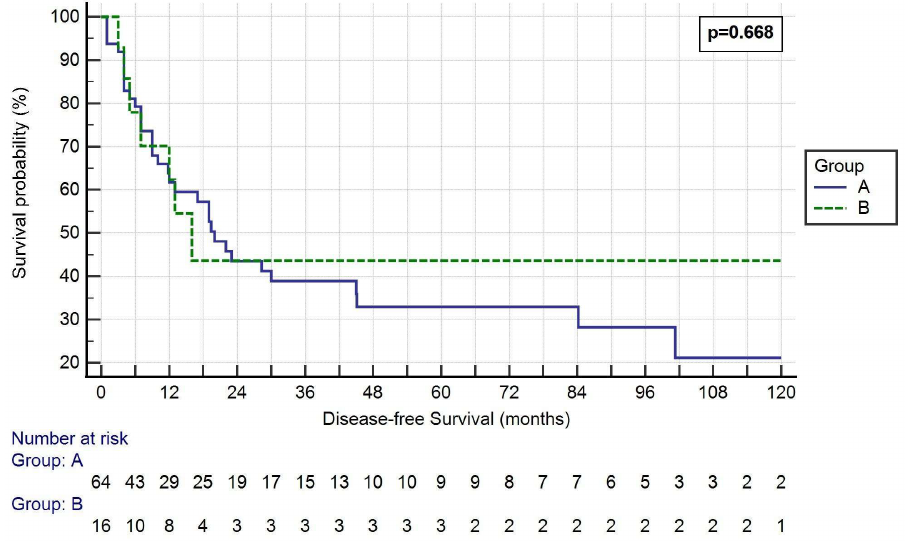
Figure 2. Kaplan–Meier curve of the DFS of the two groups. Log-rank p = 0.668. Group A: <50% SVC involvement and resection followed by direct suture or patch reconstruction; Group B: >50% SVC involvement and prosthesis reconstruction.